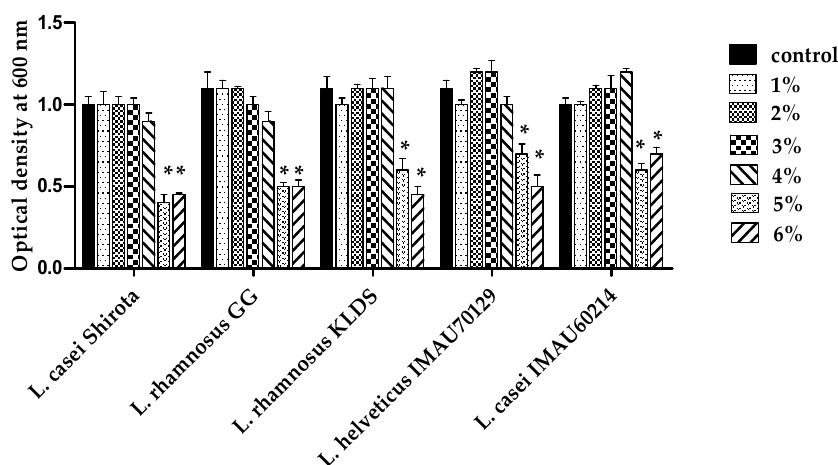
Figure 3. NaCl tolerance of Lactobacillus strains. The tolerance to different salt concentrate ions was analyzed during 18 h at 37 °C. Values represent the mean ± standard deviation (SD) of three different assays. An MRS medium without NaCl was used as the control. * significant difference among strains at concentration of NaCl-MRS.